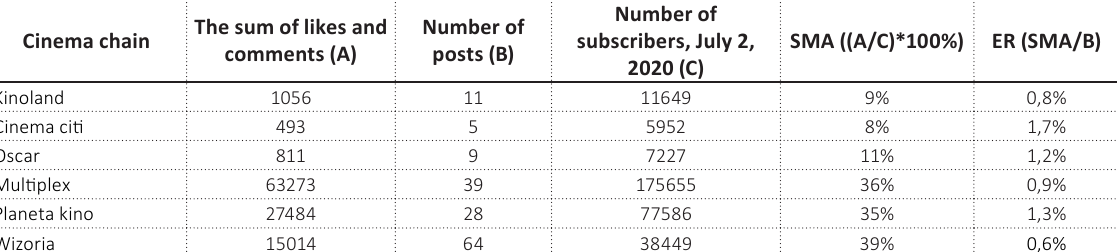
Source: Developed by researchers.